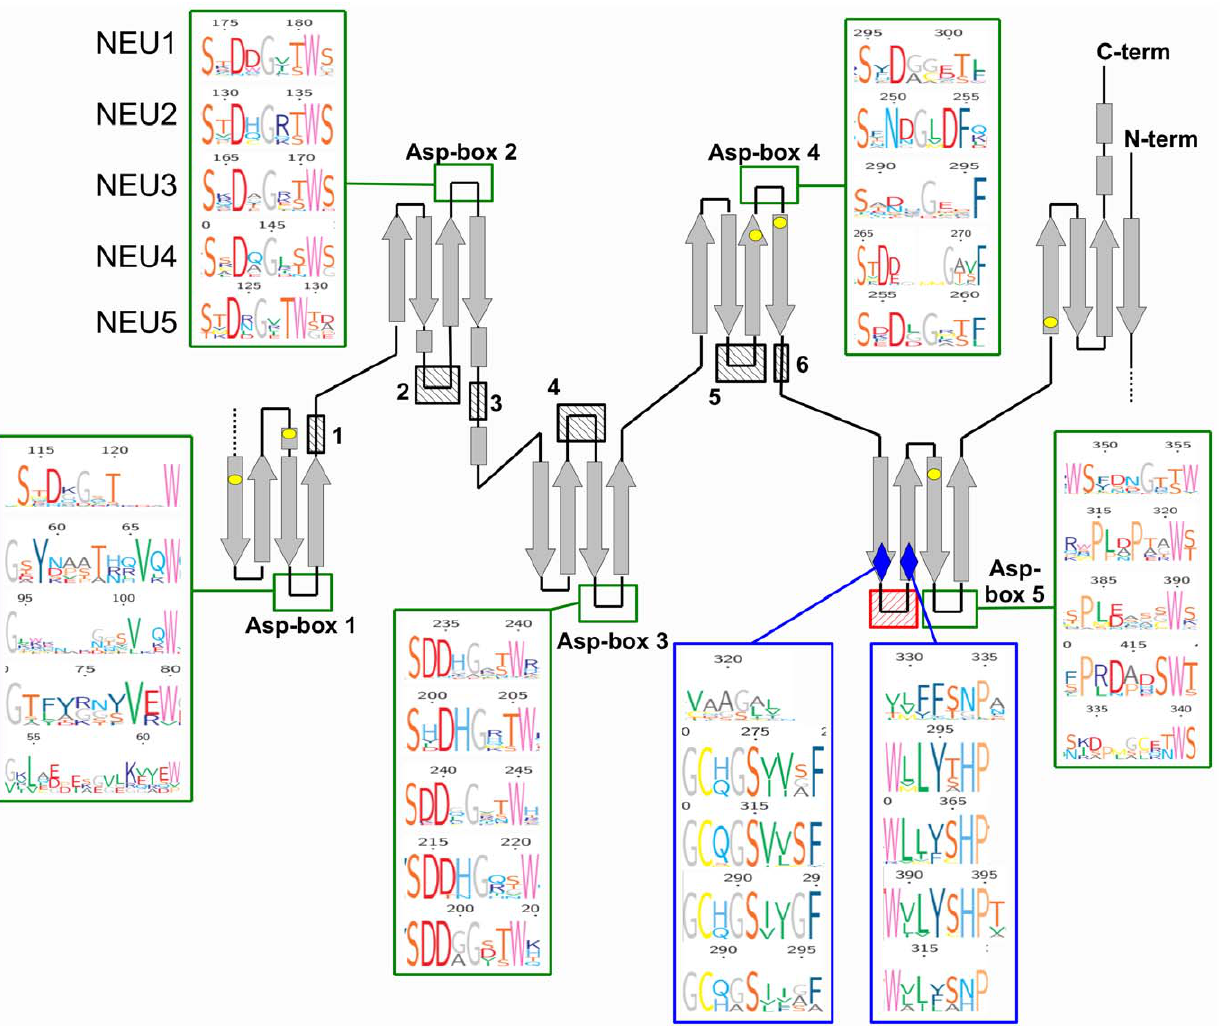
Figure 2. Schematic representation of the sialidase structure. b -sheets are represented as grey arrows, loops are depicted as black lines and the positions of the 6 key residues involved in the catalysis are indicated with yellow dots. The five Asp-boxes sites (Asp 1–5) are indicated with a green square. LOGOs representing sequence conservation in each one of the 5 sialidase subgroups are reported for each Asp-box. The black crossed boxes (1–6) indicate the loops in which large functional domains have been identified in leech, bacterial or viral sialidases. Number legend: 1: M. decora ; 2: C. perfrigens , S. pneumoniae ; 3: V. cholerae ; 4: C. perfringens , Newcastle virus, M. decora ; 5: S. tiphimurium ; 6: i nfluenza B and i nfluenza N9 viruses. The red crossed box indicates the highly variable loop identified in vertebrates, surrounded by two highly conserved sequence blocks, represented by blue diamonds. For these blocks LOGOs representation of the multiple alignments in the 5 sialidase subgroups are also reported.